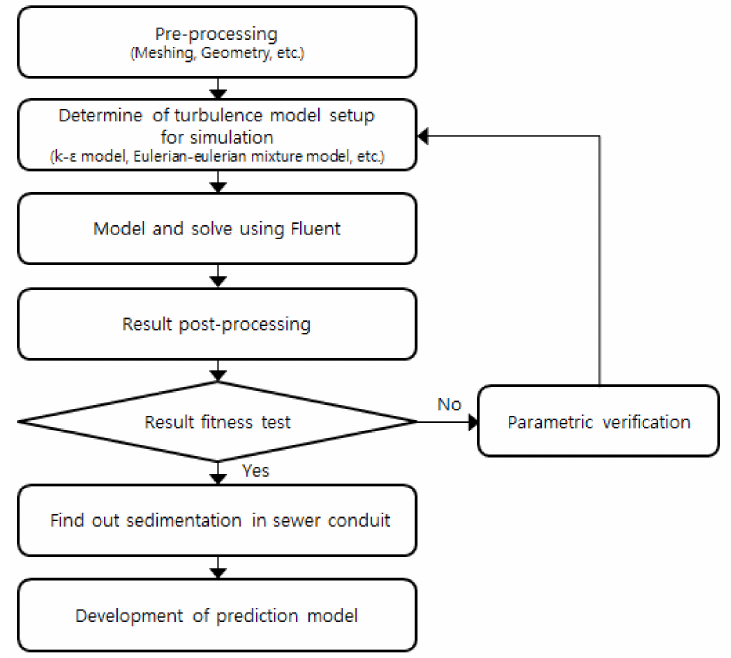
Figure 2. Flowchart of analysis